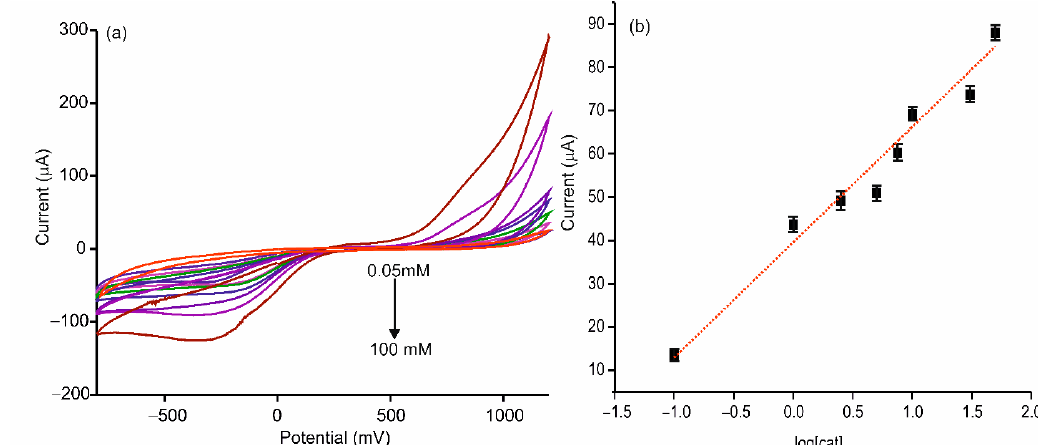
Figure 11. ( a ) Voltammetric response in a diluted wine 10% in PBS 0.01 M to addition of increasing concentrations of catechol (5 × 10 − 5 , 10 − 4 , 2.5 × 10 − 4 , 5 × 10 − 4 , 7.5 × 10 − 4 , 10 − 3 , 5 × 10 − 3 , 10 − 2 M) in 0.01 mol·L − 1 PBS, pH 7.0, ( b ) calibration curve of the response for increasing concentration of catechol.